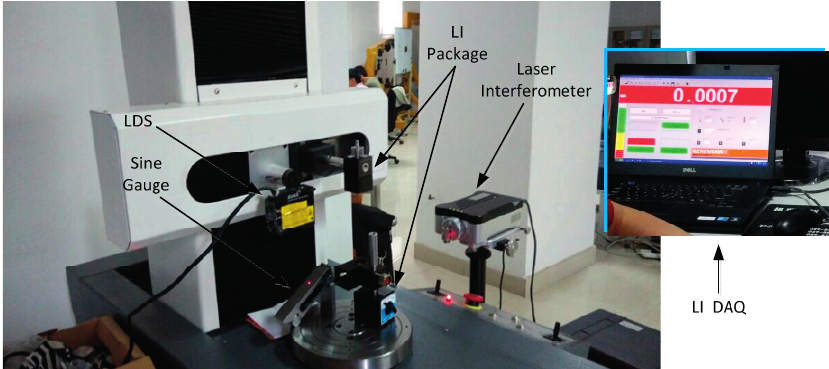
Figure 8. Inclination error